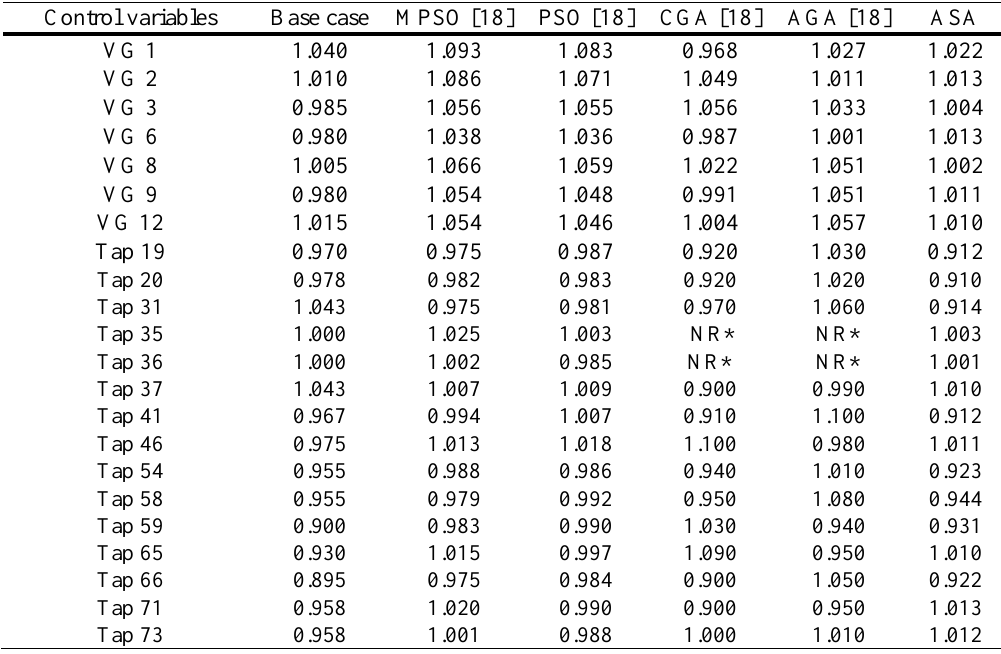
Table 3. Simulation results of IEEE −57